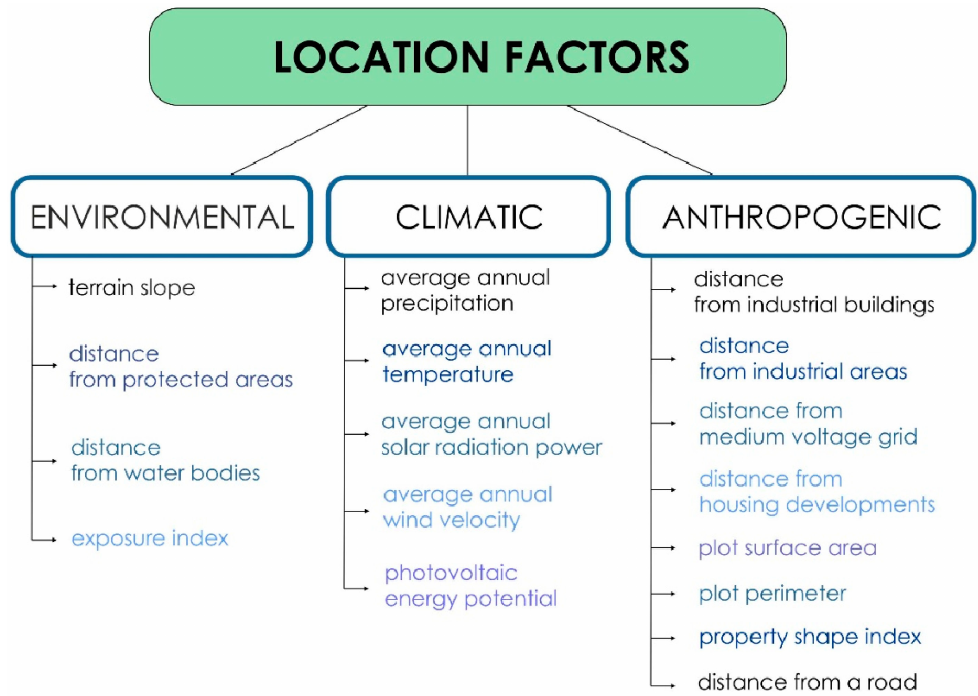
Figure 5. The PV farm location factors subjected to